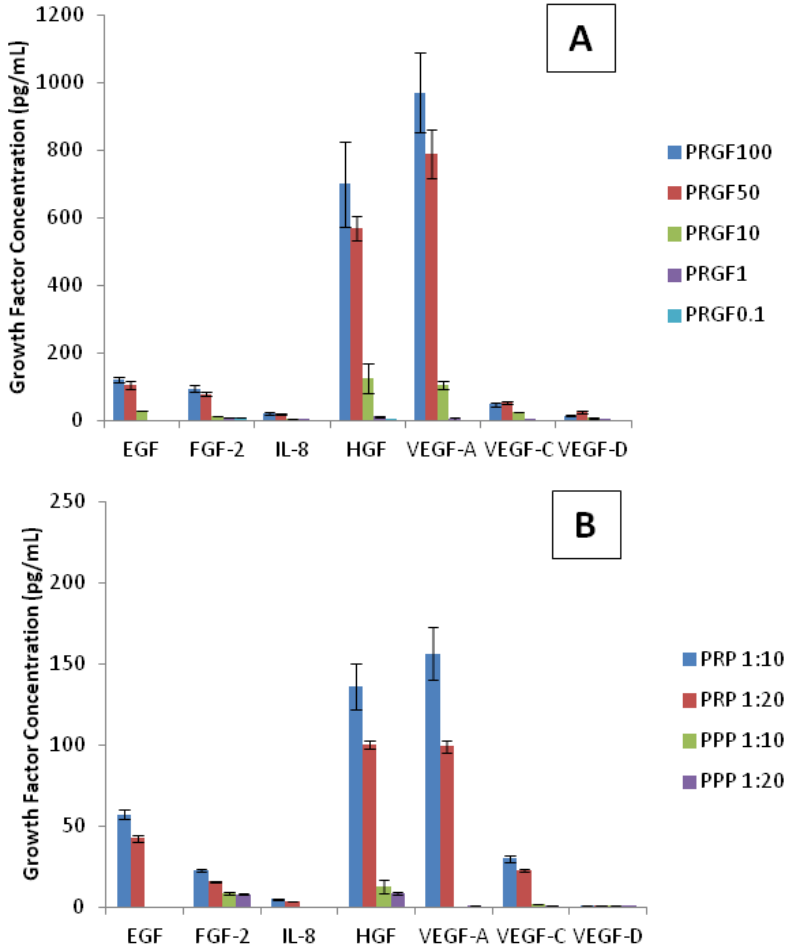
Figure 7. Growth factor analysis of ( A ) PRGF, ( B ) PRP and PPP dilutions. The highest concentrations of growth factors detected in PRGF and PRP were hepatocyte growth factor (HGF) and vascular endothelial growth factor A (VEGF-A). As expected, dilutions of PRGF and PRP recorded lower values for all growth